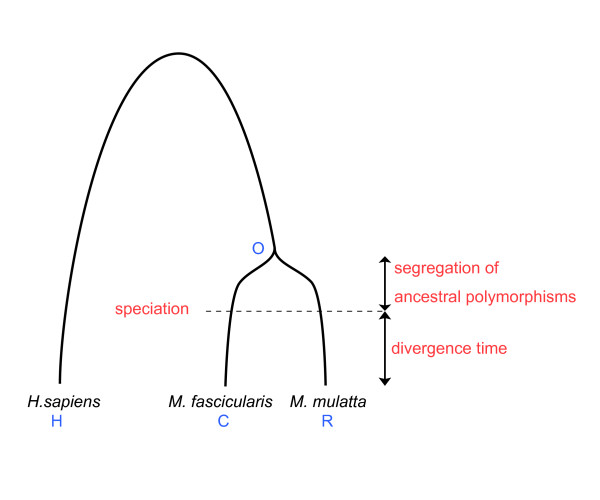
Genealogical relationship (phylogeny of genes) among the humans (H), cynomolgus macaque (C), and rhesus macaque (R). The common ancestor of the two macaques is indicated by the letter O. The time of speciation between the two macaques is shown by the dashed line. Note that the tree is unrooted.